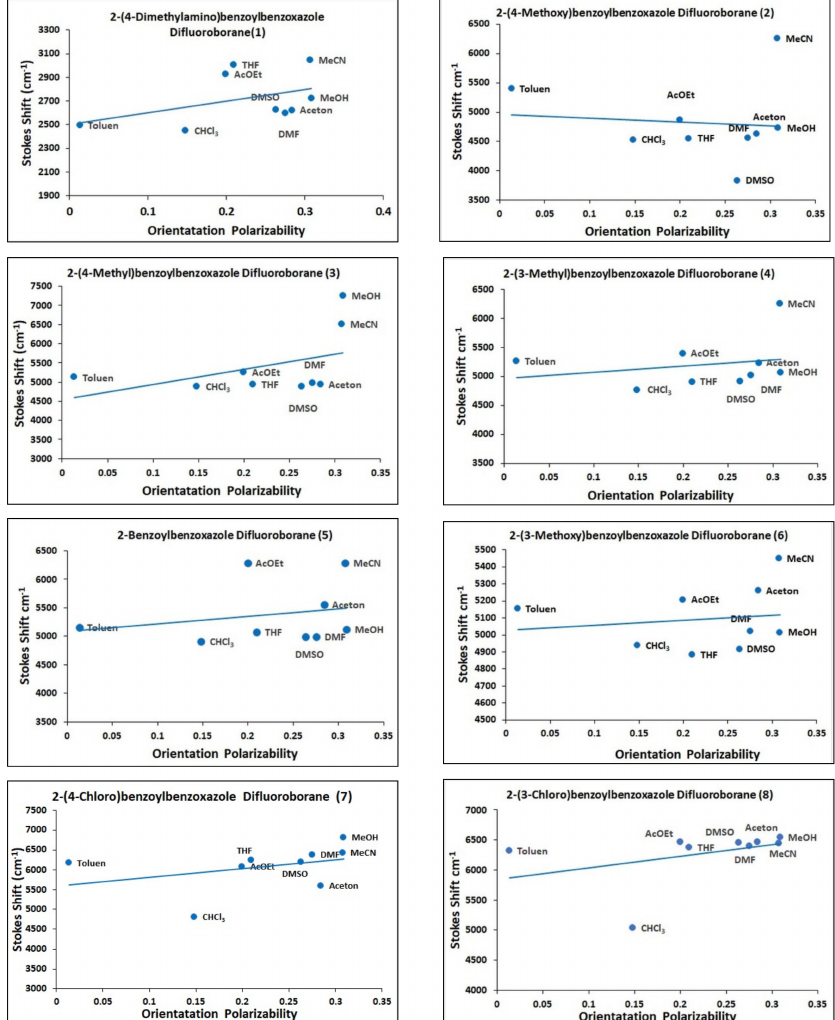
Figure 5. Lippert–Mataga plot of compounds 1 – 8